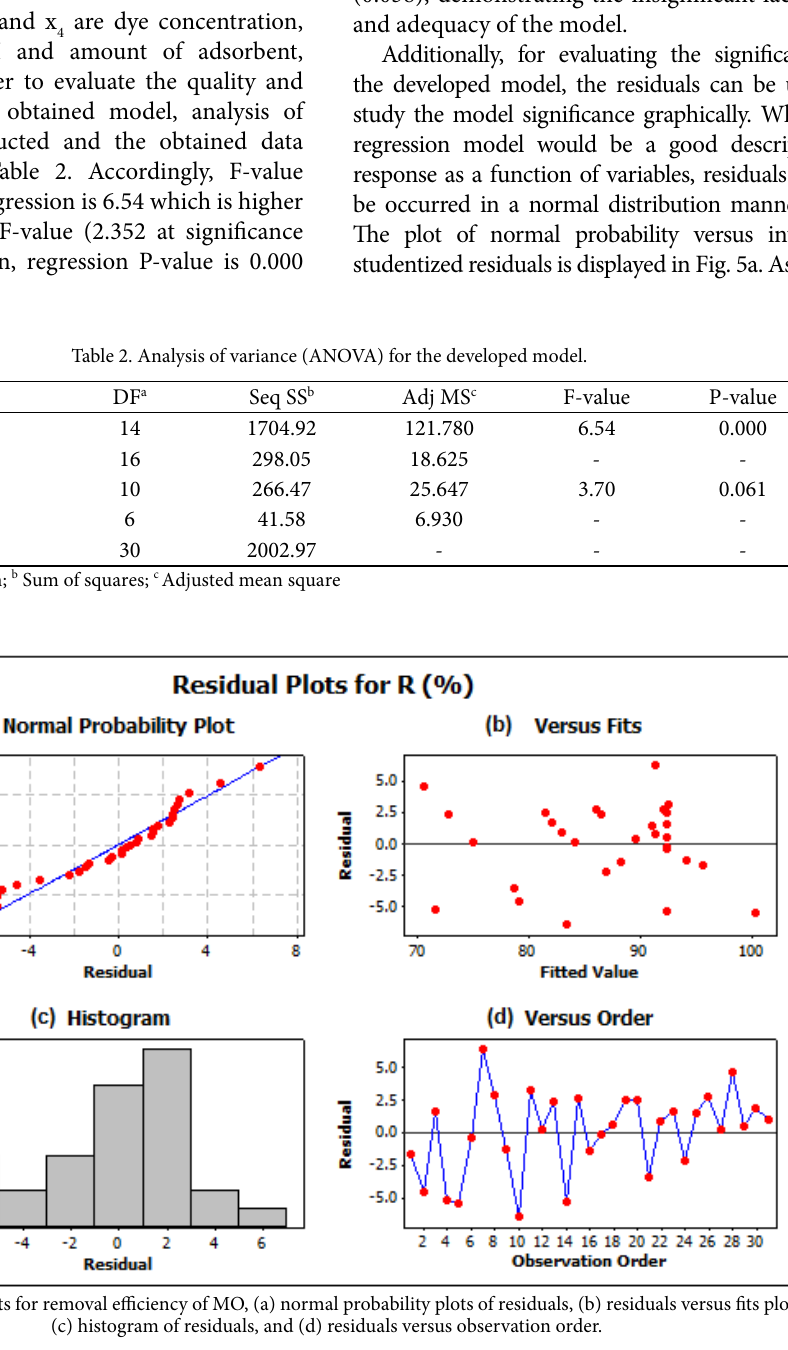
Fig. 5. Residual plots for removal efficiency of MO, (a) normal probability plots of residuals, (b) residuals versus fits plots, (c) histogram of residuals, and (d) residuals versus observation